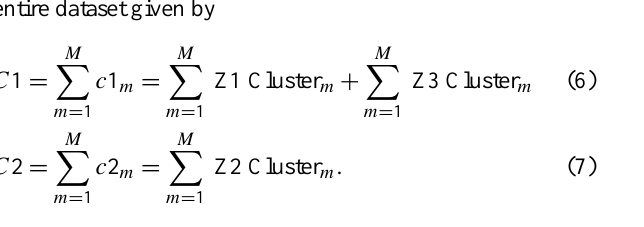
Fig. 4. Example of time zone clustering